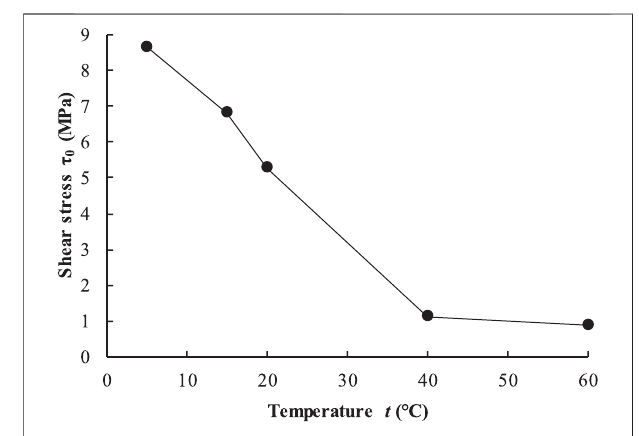
FIGURE 5 | Effect of temperature on shear